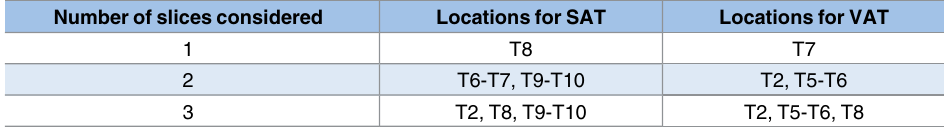
Table 5. Locations of chest slices with maximum volume-to-area correlation.